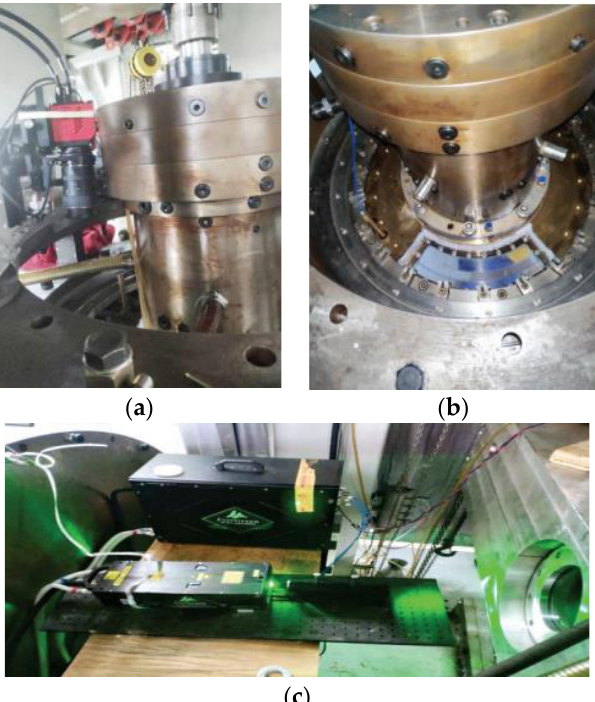
Figure 23. PIV test site [87]. ( a ) Camera placement position ( b ) Transparent glass window. ( c ) Laser incident window.